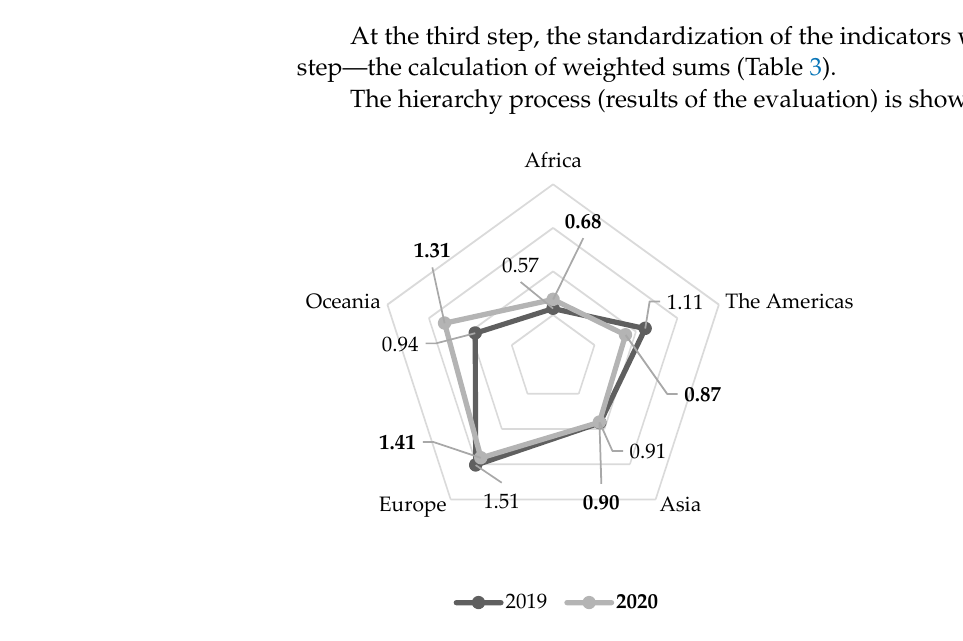
Figure 2. The green economy’s sustainability (IS) in 2019–2020. Source: authors.